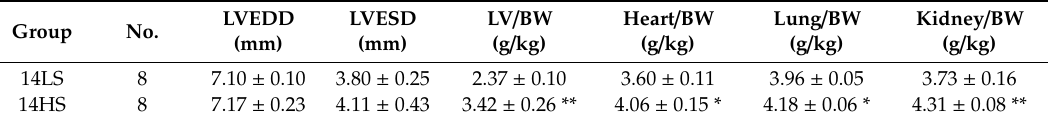
Figure 2. Severely impaired systolic contractile function in free wall (FW) and interventricular septum (IVS) of high-salt (HS)-fed DSS rat hearts. ( A – D ) Representative images of radial strain curves in FW and IVS in low-salt (LS)-fed and HS-fed rat hearts at the age of 14 weeks. The color lines represent the radial strain curves corresponding to the six myocardial segments, and the black line refers to the averaged strain curve over free wall or interventricular septum, where the arrow points to the peak value. ( E and F ) Peak radial strains in FW and IVS in LS-fed and HS-fed rat hearts. ( G – J ) Peak longitudinal strains on the endocardium and epicardium of FW and IVS in LS-fed and HS-fed rat hearts ( n = 10 in LS group and n = 15 in HS group). * p < 0.05, ** p < 0.01, **** p < 0.0001. Table 1. LV diastolic and systolic diameters and ratios of heart, LV, lung, and kidney weights to BW in HS and LS groups at the age of 14 weeks.